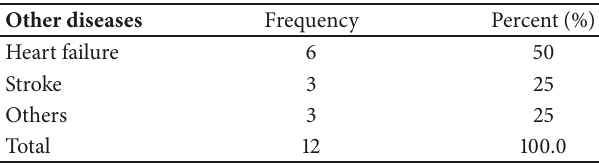
Table3:EpilepticpatientswithotherchronicillnessatDRH,Dessie, Ethiopia, from April to June 22